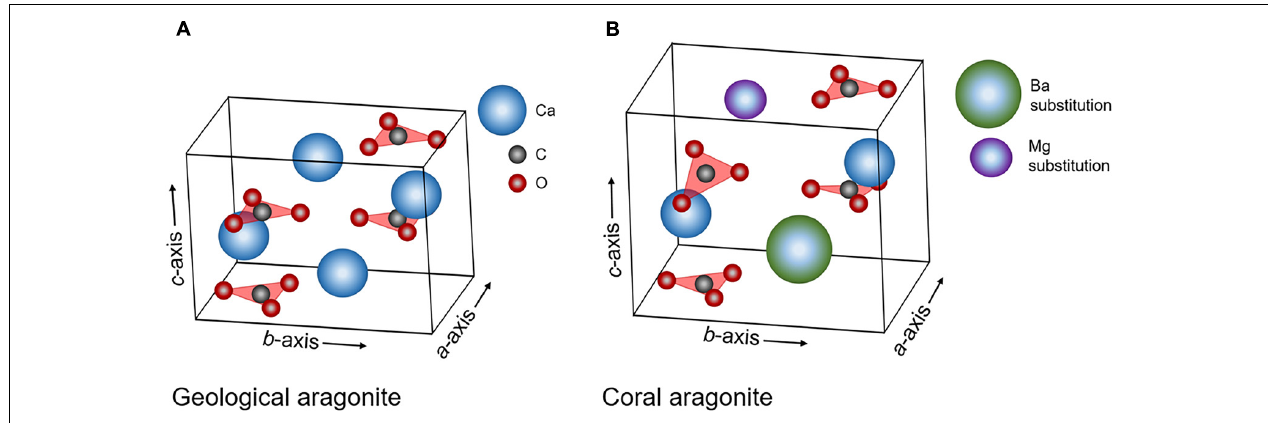
FIGURE 8 | Schematic of the aragonite unit cell with labeled a -, b -, and c - axes and positions of trigonal planar carbonate groups and calcium ions. (A) Aragonite under normal conditions, (B) aragonite with longer axes lengths, larger overall volume, distorted symmetry (static out-of-plane rotations of the carbonate groups), and potential trace-incorporations by other elements for Ca. This figure is not to scale and length expansions, distortions and substitutions are exaggerated for effect.